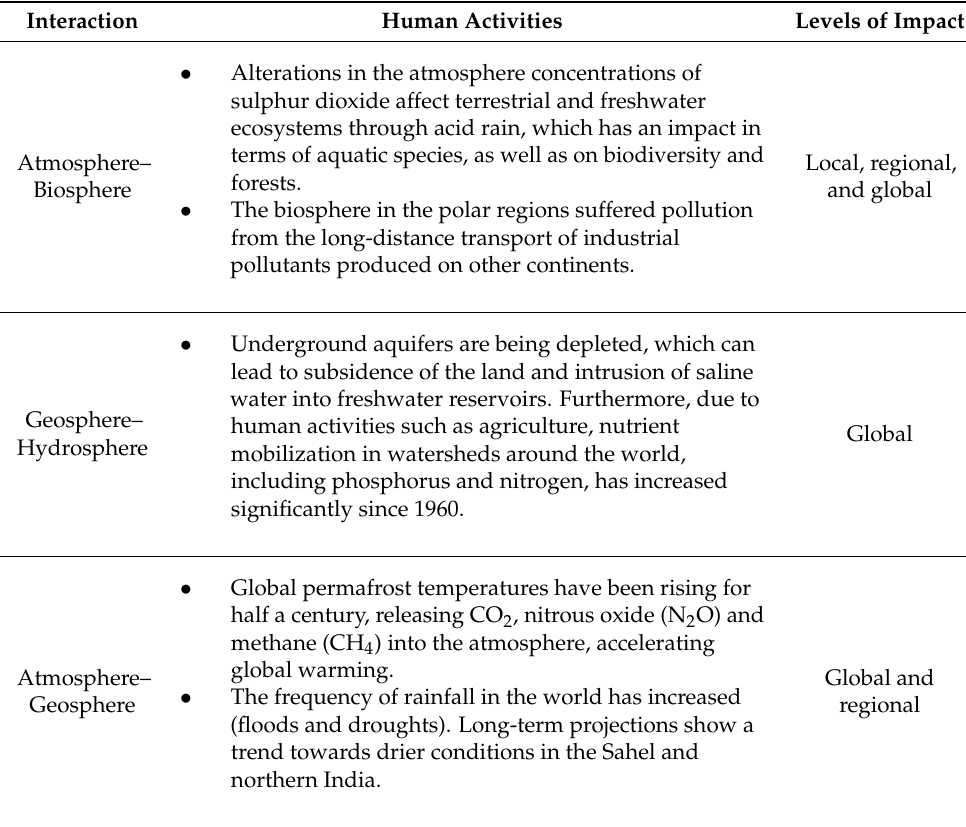
Figure 3. Dynamics of the composition of the atmosphere. Source: [78]. Global Atmosphere Watch Programme (GAW). Available online: https://community.wmo.int/activity-areas/gaw, accessed on 1 April 2021. Table 2. Interactions in the earth system that are affected by human activities.